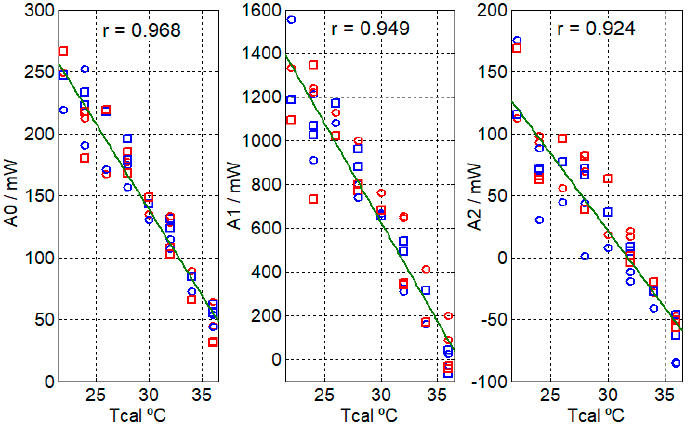
Figure 8. Coefficients A 0 , A 1 and A 2 of the heat flux (Equation (5)) of the right hand (blue points) and the left hand (red points) of a healthy 23-year-old male subject, measured with the minisensor S1 (round) and the minisensor S2 (squares) for different thermostat temperatures ( Tcal ). r is Pearson’s correlation coefficient.